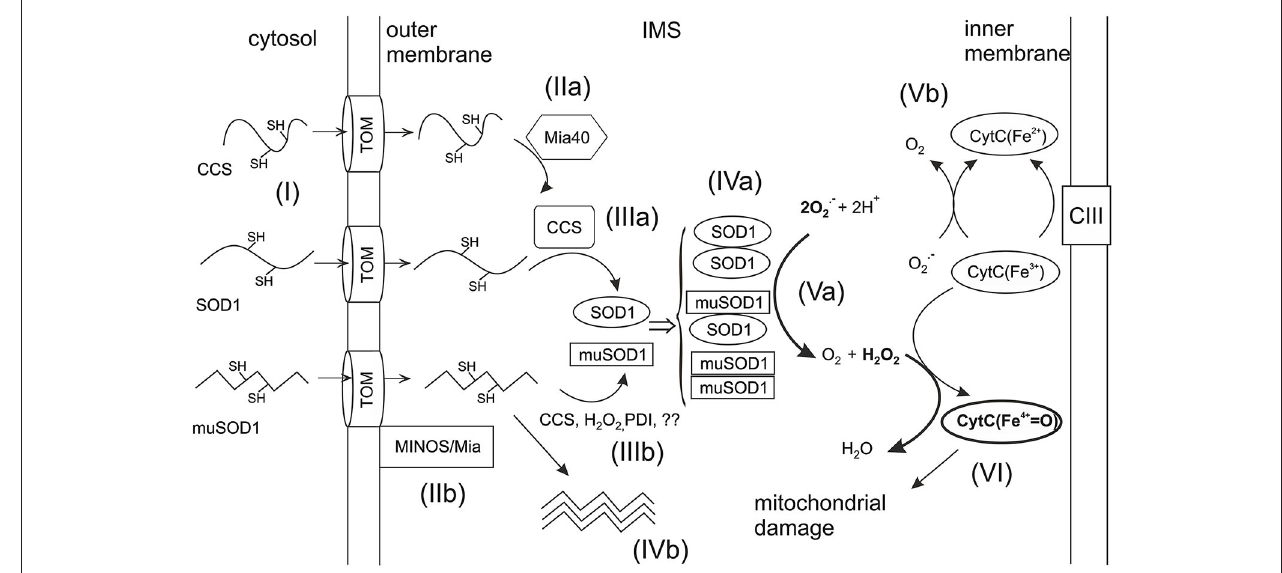
known mechanisms such as oxidization by H 2 O 2 or protein disulfide isomerase (PDI)—type of oxidoreductase (IIIb). Alternatively, mutants unable to fold correctly may form oligomers in IMS (reaction IVb). The disulfide oxidized mature monomers form the active enzyme by dimerization (reaction IVa). In ALS, mutant and wt homodimers may co-exist with heterodimers. Mature dimeric SOD1 dismutates superoxide (O 2 − ) to O 2 and H 2 O 2 (reaction Va). Alternatively, superoxide may react with CytC 3 + which oxidizes it to O 2 (Vb). CytC 3 + can also catalyze peroxidation in the presence of H 2 O 2 yielding oxoferryl-cytC (CytCFe 4 + ) which as a highly reactive oxidant may cause mitochondrial damage (reaction VI). The critical reactions (Va and VI) leading to mitochondrial damage are marked with bolded